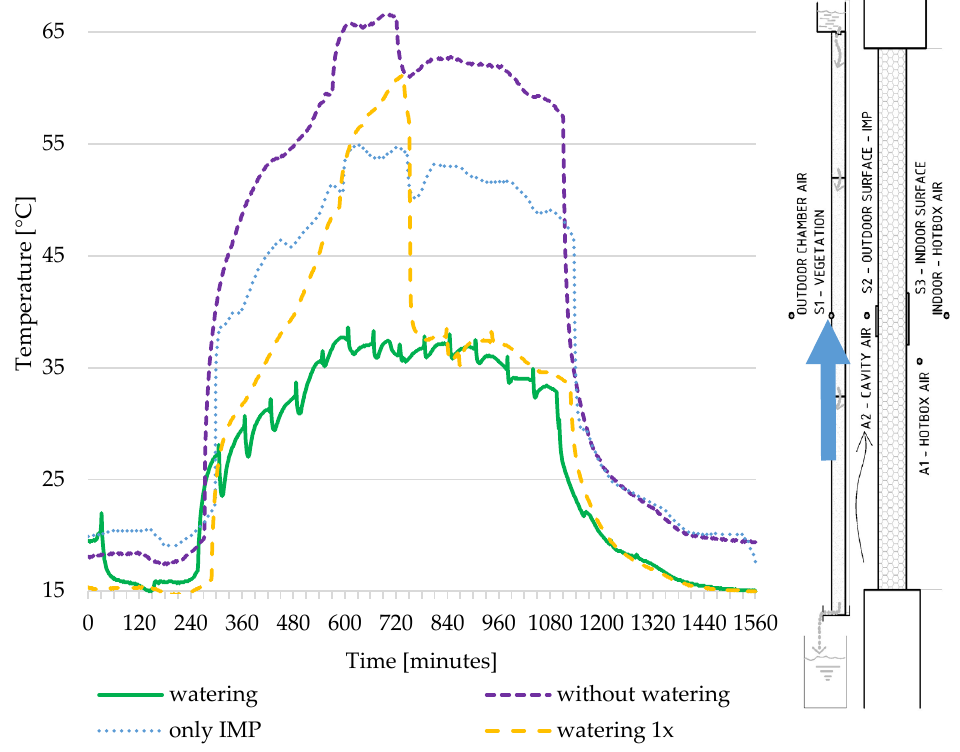
Figure 9. The temperature courses of the vegetation board surface based on the different watering regimes and comparison to the IMP-only setup.